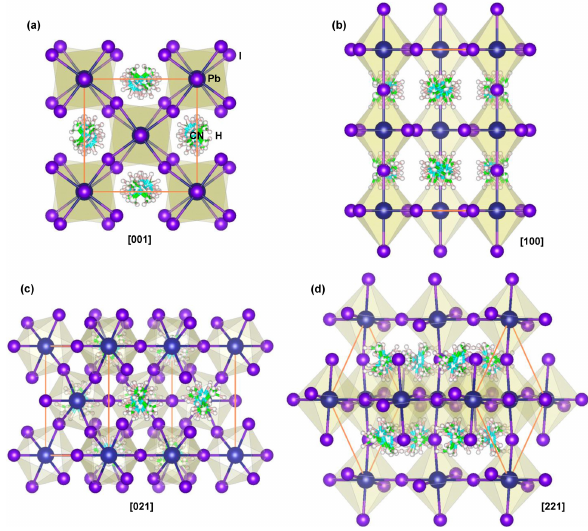
Figure 14: Structural models of tetragonal CH 3 NH 3 PbI 3 observed along (a) [001], (b) [100], (c) [021], and (d) [221].